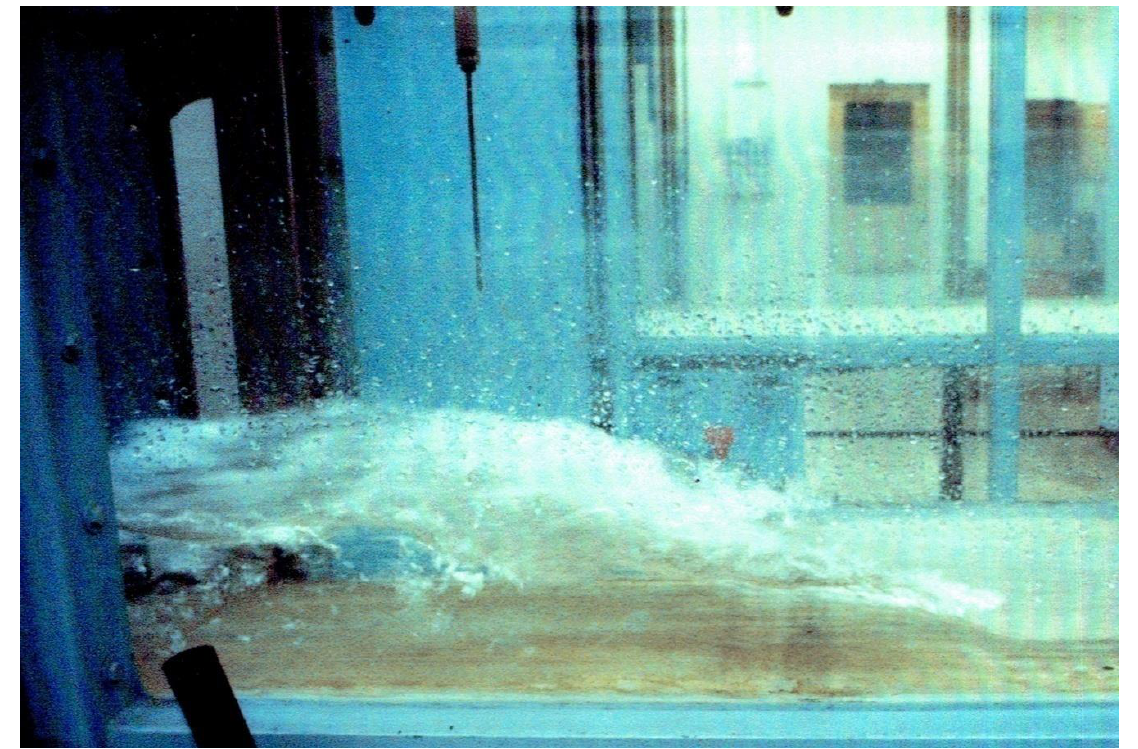
Figure 19. Actual hydraulic jump caused by a high velocity (right-to-left) Froude number water flow (Fr >> 1) encountering a submerged plate obstacle at the leftmost exit of a hydraulic flume. (Photo by C. Ortloff).